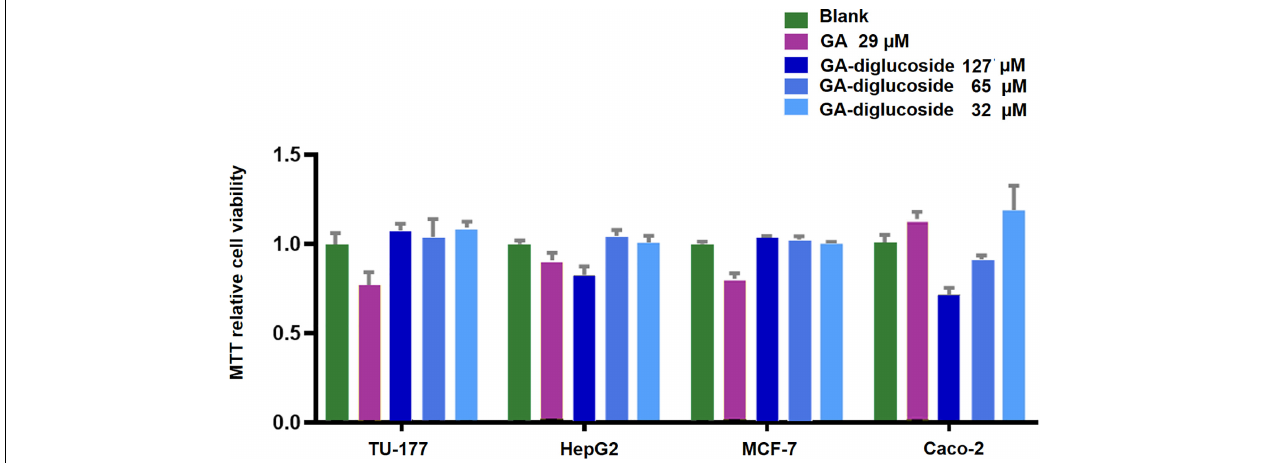
FIGURE 7 | MTT Assay. Different cell lines were treated with GA or GA-diglucoside and then the cell viability was measured using the MTT assay. The result exhibited a dose-dependent cytotoxic of GA-diglucoside toward human colon carcinoma Caco-2 cell line, with an IC50 at 160